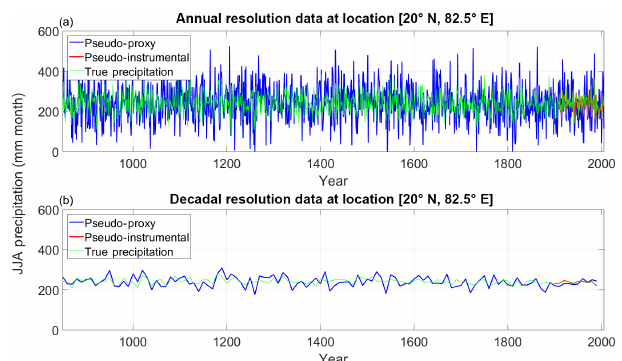
Figure 2. Example of pseudo-proxy, pseudo-instrumental and true precipitation time series at location [20 ◦ N, 82.5 ◦ E]. (a) Annually resolved data. (b) Decadally resolved